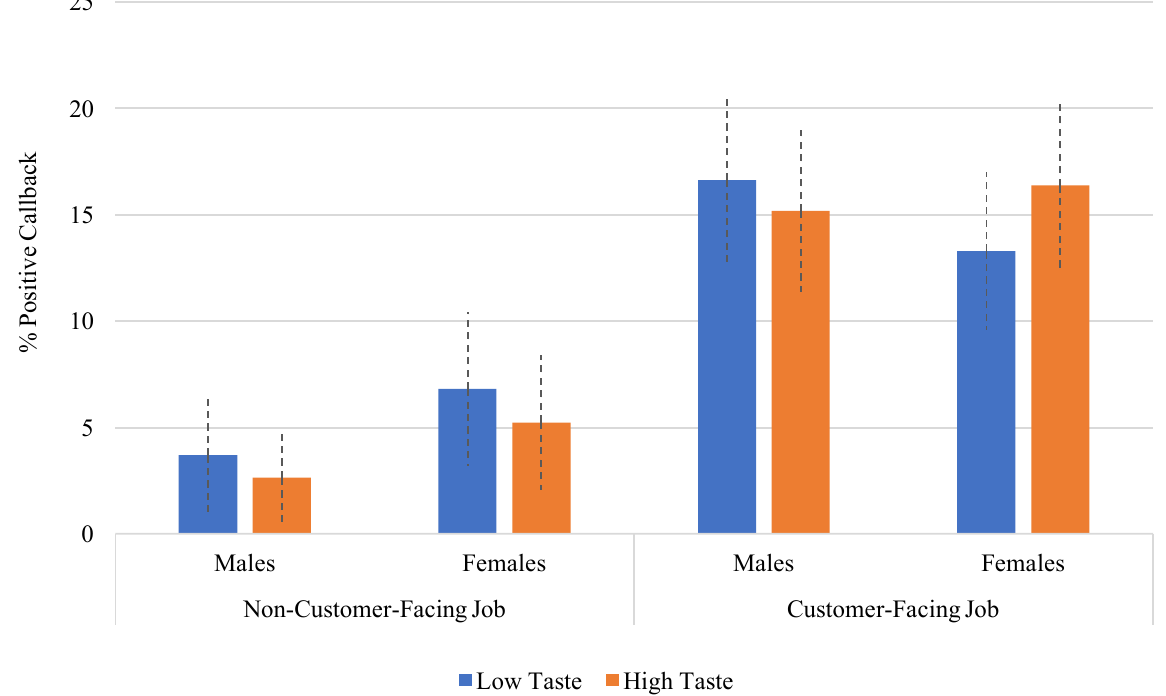
Figure 2: Effect of signals of cultural taste on rates of positive callback. Dashed lines represent confidence